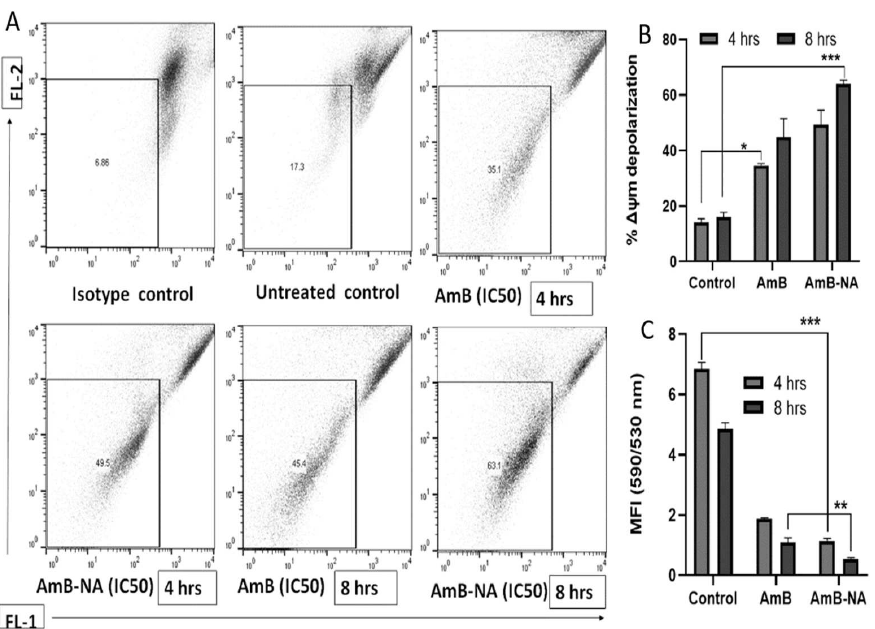
Figure 6. Effect of AmB-NA on the mitochondrial membrane potential of L. donovani promastigotes. The effect of AMB-NA formulation on L. donovani promastigotes mitochondrial membrane was determined. A known population of L. donovani promastigotes (1 × 10 6 /mL) was treated with as-synthesized AmB-NA for 4–8 h at 24 °C. The AmB-NA treated parasites were stained with JC-1 as described in the method. ( A ) FACS analysis of JC-1 mitochondrial potential marker staining 4 h and 8 h post-exposure with AmB-NA formulation. Panels represent density plots from a single analysis. ∆ ψ m depolarization monitored in the upper panel correspond to cells with intact mitochondrial membrane, whereas cells gated in the lower panel depicted damaged membrane of the treated cells with a loss of ∆ ψ m. ( B ) Graphic representation of mean values of the fluorescence corresponding to the mitochondrial membrane potential of the treated cells ( ∆ ψ m collapse ± SD). ( C ) MFI was calculated employing a ratio of fluorescence at 590/530 nm. Asterisks (*) denote p values determined by one-way ANOVA analysis: *** p < 0.0001 compared with control, ** p < 0.001 compared with control, * p < 0.01 compared with the control. Analyzed data derived from at least 4 independent experi- ments.